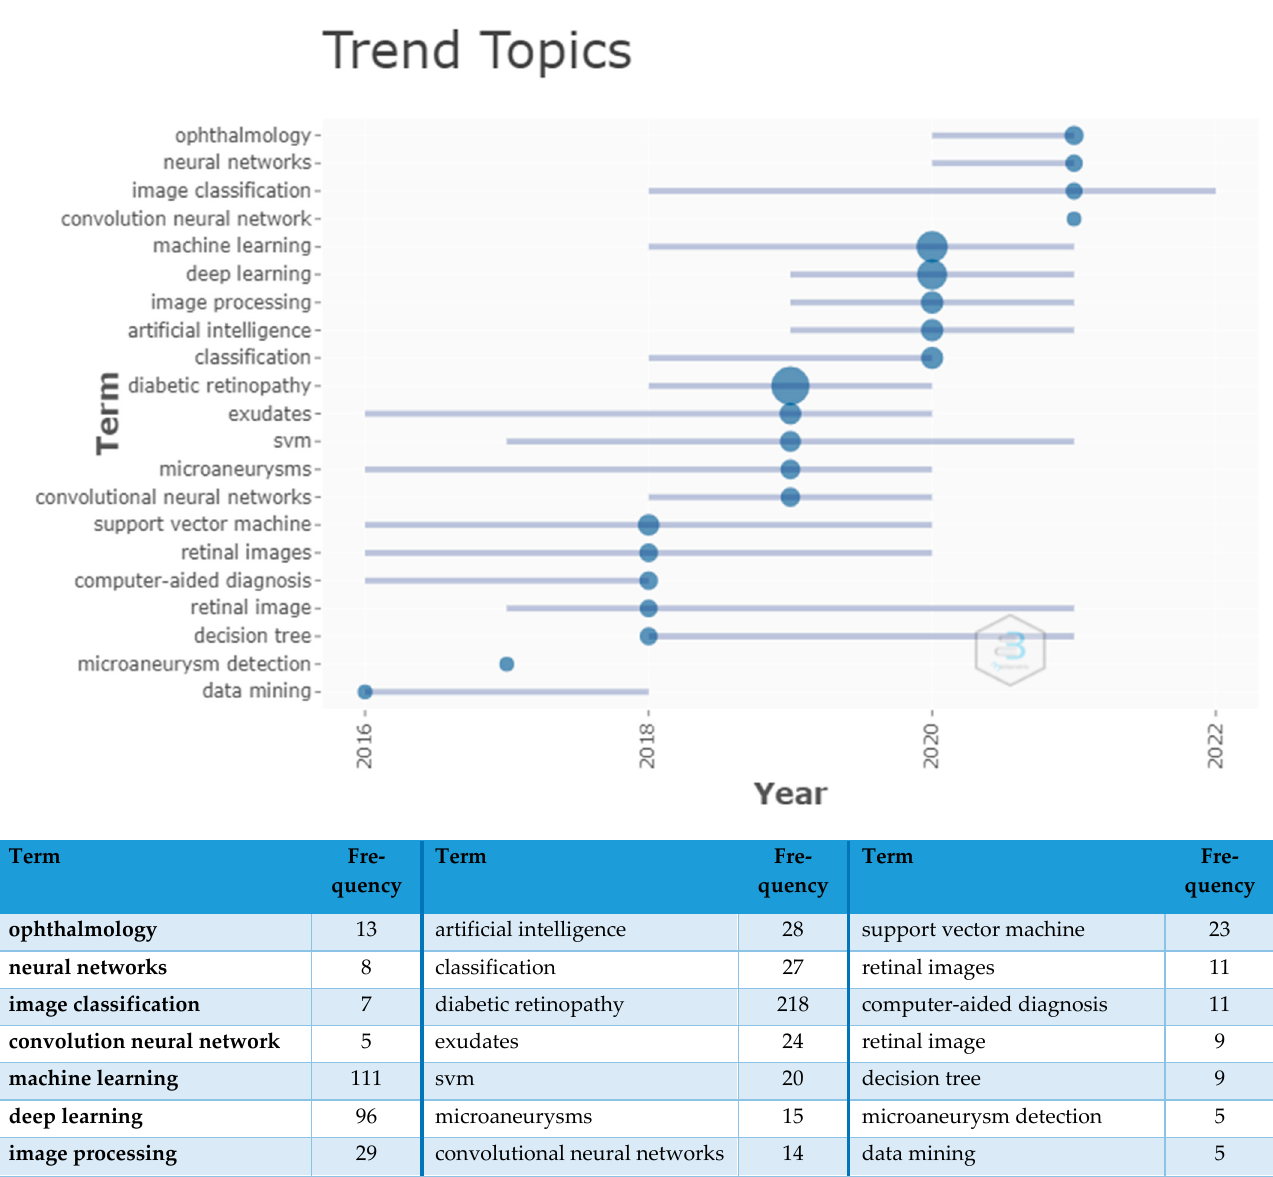
Figure 14. Trend topics over